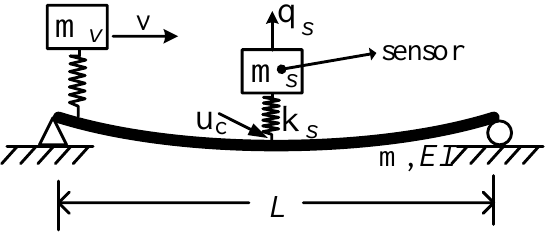
Figure 2. Stationary vehicle response to a vehicle moving over a simply supported beam.